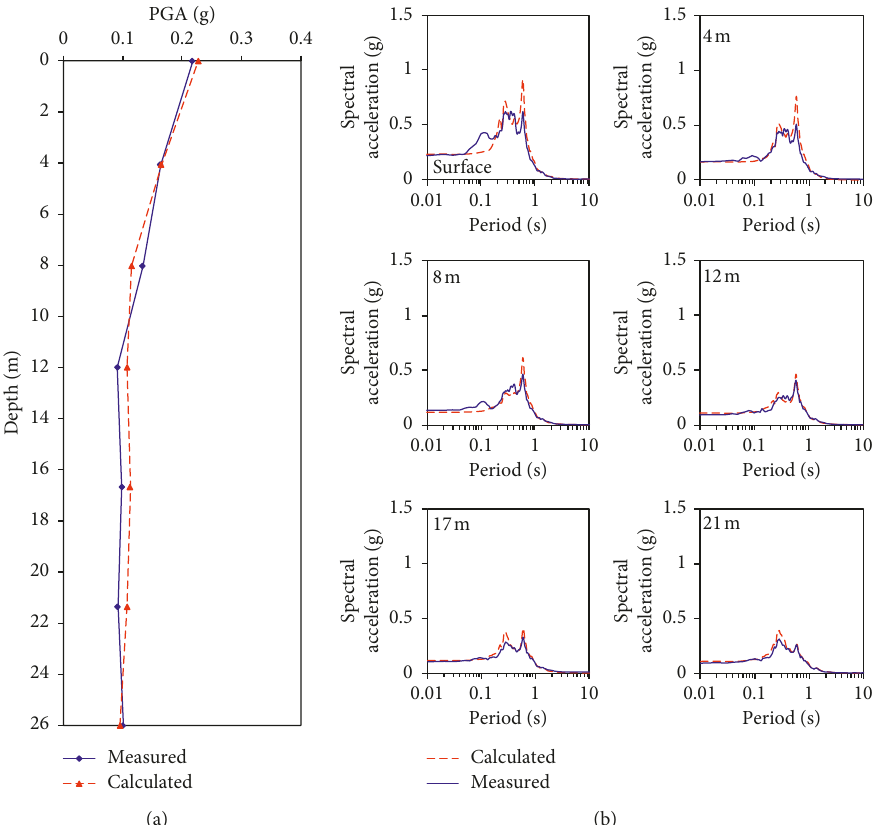
Figure 7: Comparison of the measured and calculated free-field responses. (a) PGA profile. (b) Acceleration response spectra at various